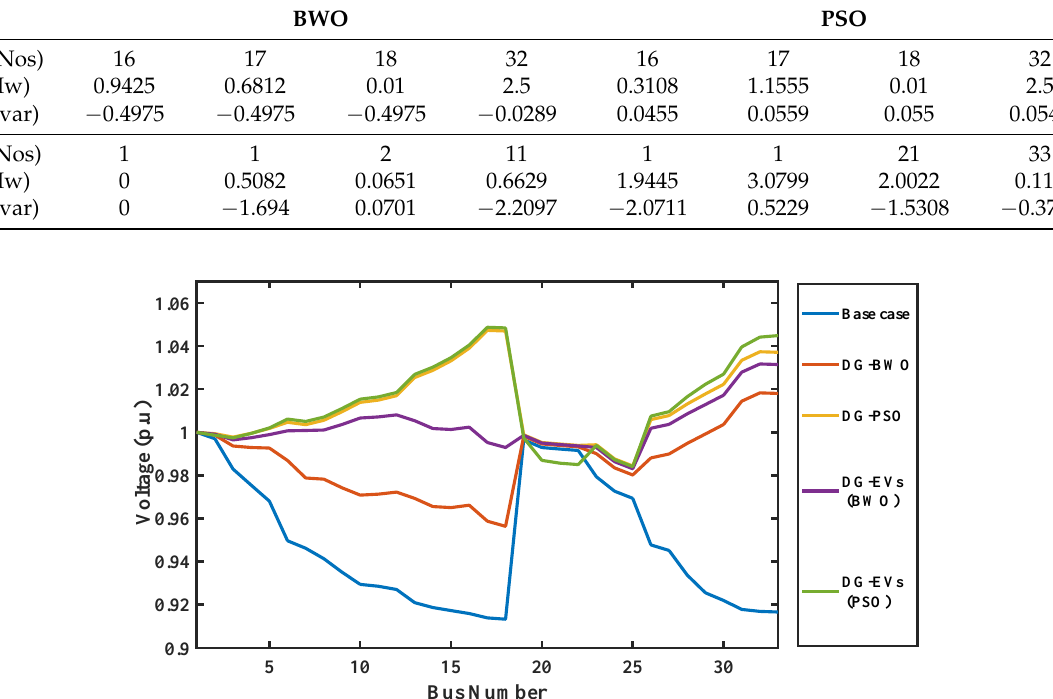
Figure 8. Voltage profile of modified test system using BWO and